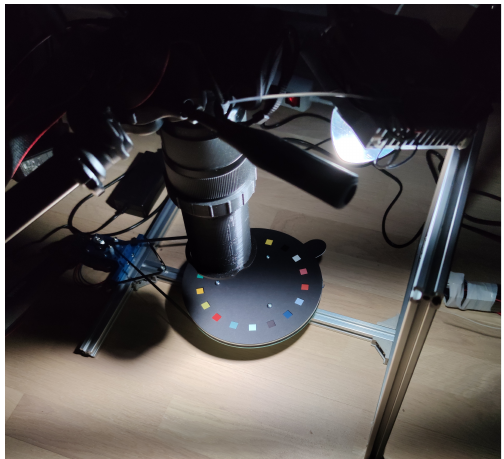
Figure 6. Imaging setup for the Canon M3 camera and the full-spectrum LED illuminant. Other cameras were setup in a similar way, adapting to the camera. The color targets were on a paper disc with a dark mask over each color patch exposing a 1cm by 1cm area of the color patch. The light was mounted to the side of the camera at an angle to reduce the effect of reflection from the surfaces of the color patches. The paper discs were mounted on to a acrylic disc and secured by three screws. The acrylic disc was rotated by a stepper motor via a timing